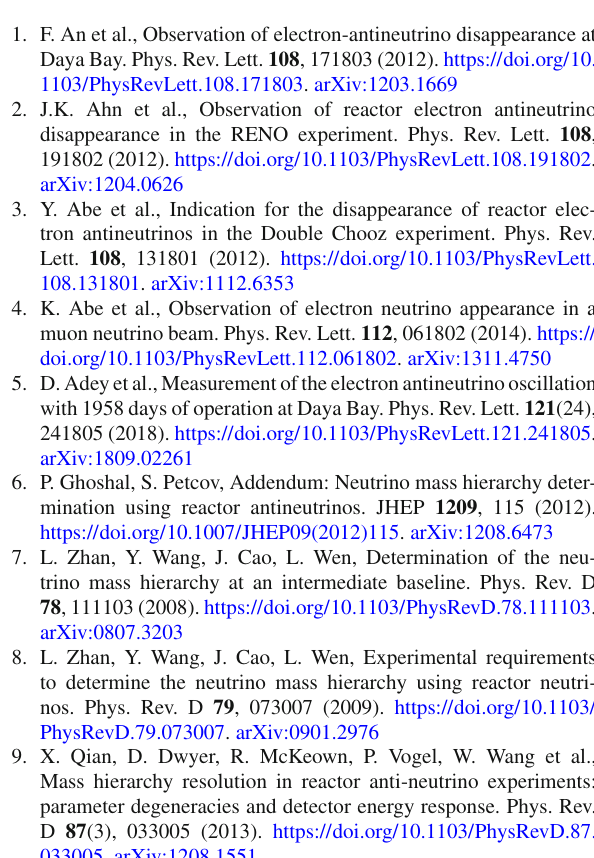
of non-linearity, detection efficiency, background estimation, etc could be